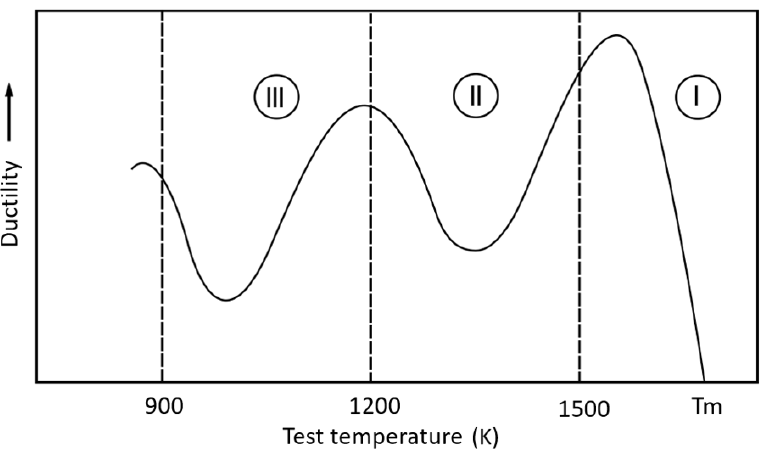
Figure 2. Schematic representation of temperature regions with reduced ductility redrawn from [16] (with the permission of Elsevier). For further details, see [16].